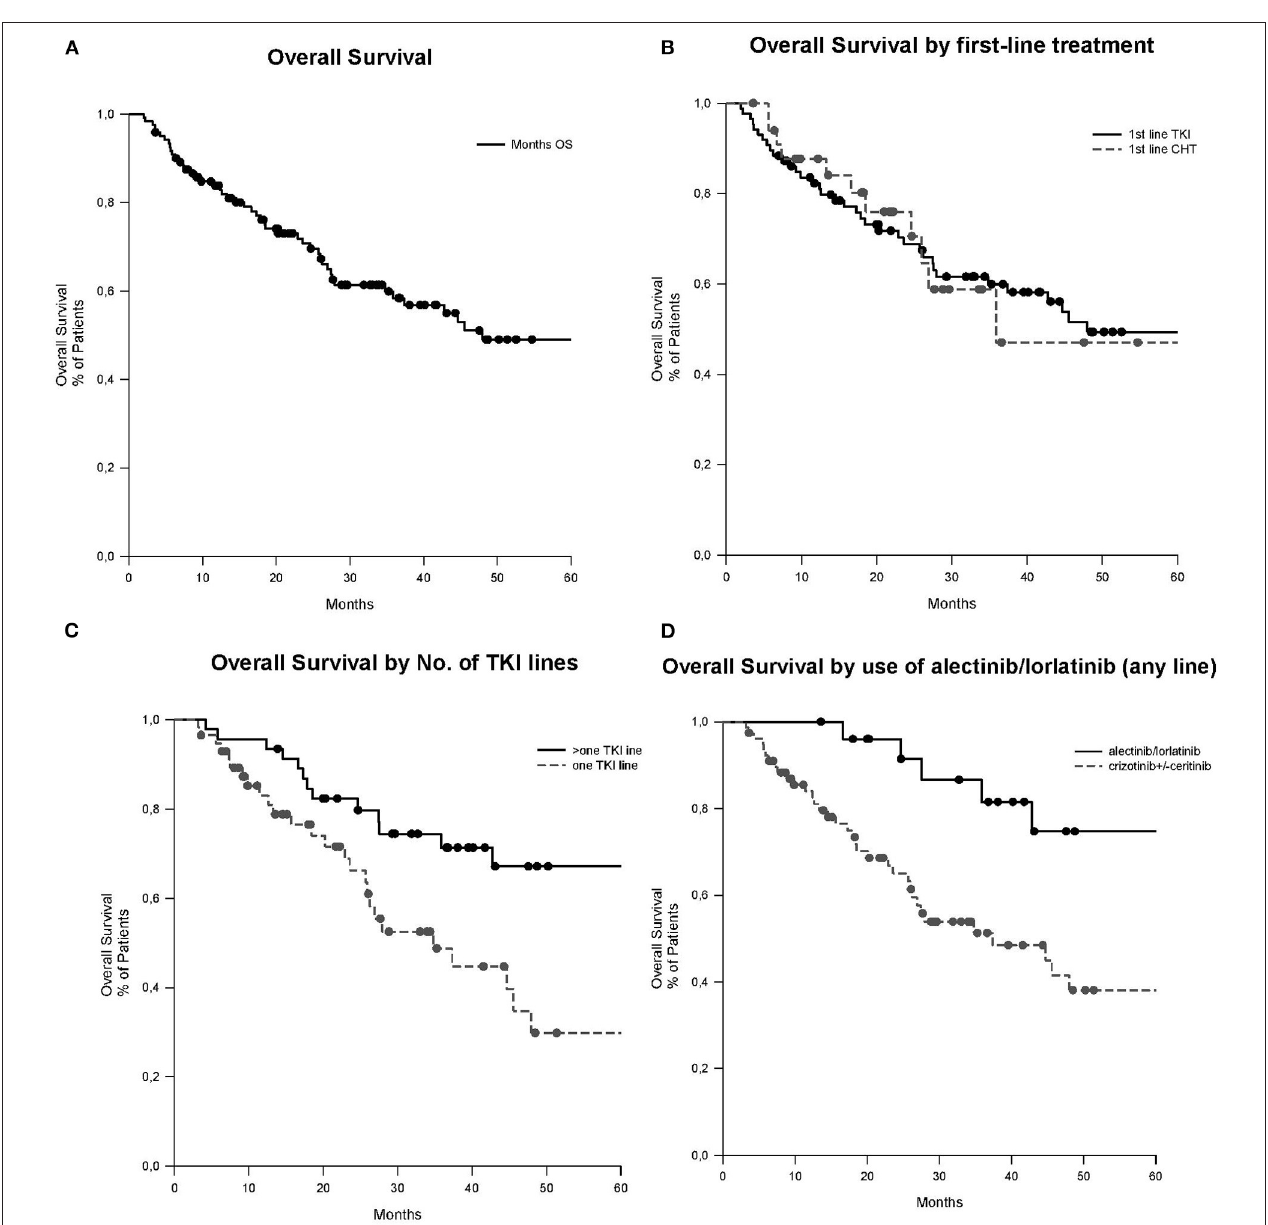
FIGURE 1 | OS curves (median follow-up of 39.5 months, 95% CI: 32.1–77.7). (A) OS of all patients, median 48.0 months (95% CI: 12.9–83.0). (B) OS according to the first-line of treatment, first-line TKI median 35.8 months (95% CI NA) vs. first-line ChT 48.0 months (95% CI: 11.8–84.1) ( p = 0.955). (C) OS according to the number of lines of TKIs, > one line of TKIs median 85.7 months (95% CI: 63.9–107.5) vs. one line of TKI 34.8 months (95% CI: 21.6–48.0; p = 0.016). (D) OS according to the use of alectinib or lorlatinib in any line. Alectinib/lorlatinib median 85.7 months (95% CI: 64.0–107.5) vs. crizotinib ± ceritinib 37.3 months (95% CI: 16.1–58.6; p = 0.022). ChT, chemotherapy; CI, confidence interval; NA, not assessable; No., number; OS, overall survival; TKI, tyrosine kinase inhibitor.